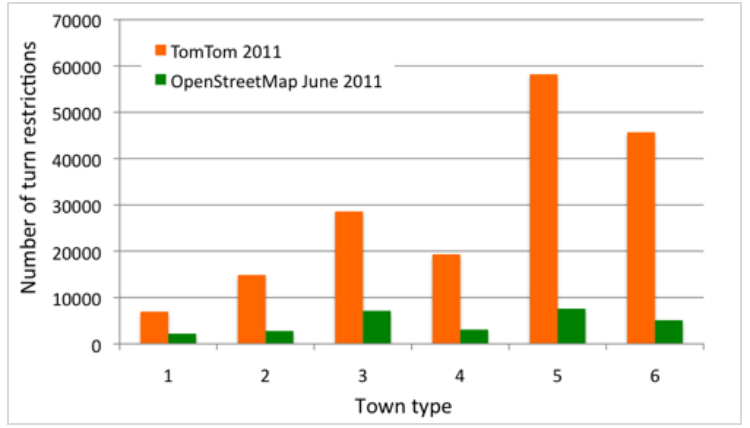
Figure 15. Number of Turn Restrictions by Town Type in Germany for TomTom and OSM (June 2011).